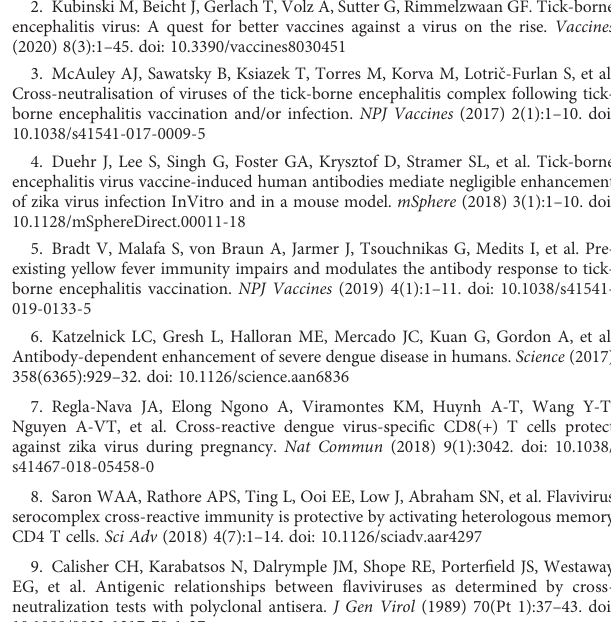
Box plots of the hematoxylin and eosin (H&E) scoring values for “ cellular necrosis ” (A, D) , “ perivascular in fl ammation ” (B, E) and “ microgliosis ” (C, F) of